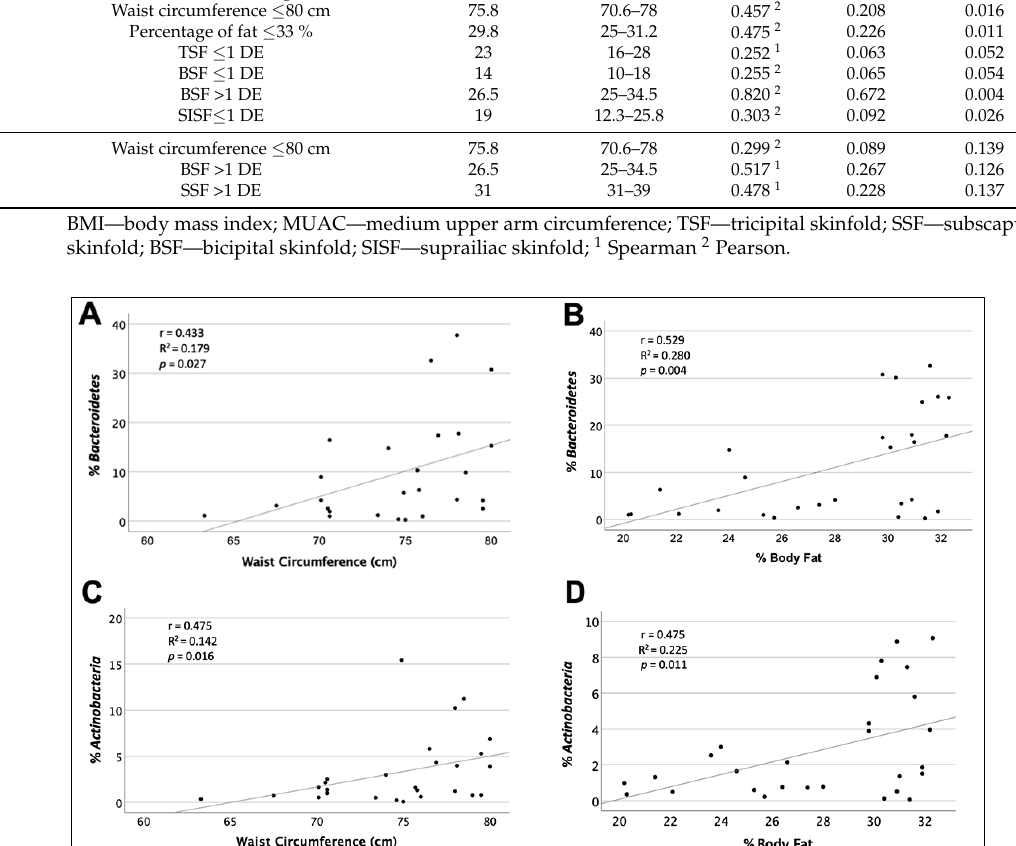
BMI ≥ 25 ( p = 0.047, adjusted R 2 = 0.114). 4 . Discussion The percentages of the bacterial phyla in human milk showed quite wide interquar- tile ranges. Despite the fact that our study included only mature milk and all of the sam- ples were obtained in the same geographic region, a wide range of distributions was found among the proportions of the phyla studied. This great individual variability has already been described and, although it has been little studied, it has been associated with factors like geographical region, the stage of lactation, and the route of birth [1,26,27]. This study represents a window of opportunity to achieve a better understanding of the human milk microbiota. The percentage of Bacteroidetes was directly correlated with the prepregnancy BMI, current BMI, waist circumference, and percentage of body fat when these indicators of adiposity were within the limits considered normal. However, this correlation was inverse when the cutoff points considered healthy were exceeded. These findings are similar to those observed by other authors for the intestinal microbiota [26,28,29], who described a higher proportion of Bacteroidetes in the human intestine associated with a normal BMI and a decrease in this phylum with a higher BMI. Both BMI at the time of the study and prepregnancy BMI showed significant correla- tions with the percentage of Bacteroidetes , directly when BMI was in ranges considered healthy and inversely when BMI was greater than 25 points. These findings could mean that the abundance of this phylum in human milk is influenced by maternal nutritional